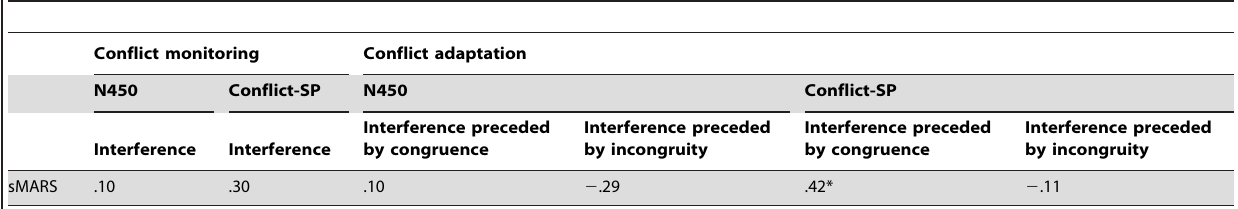
Table 5. Pearson correlation coefficients between the sMARS scores and ERP measures for conflict monitoring and conflict adaptation for the whole sample